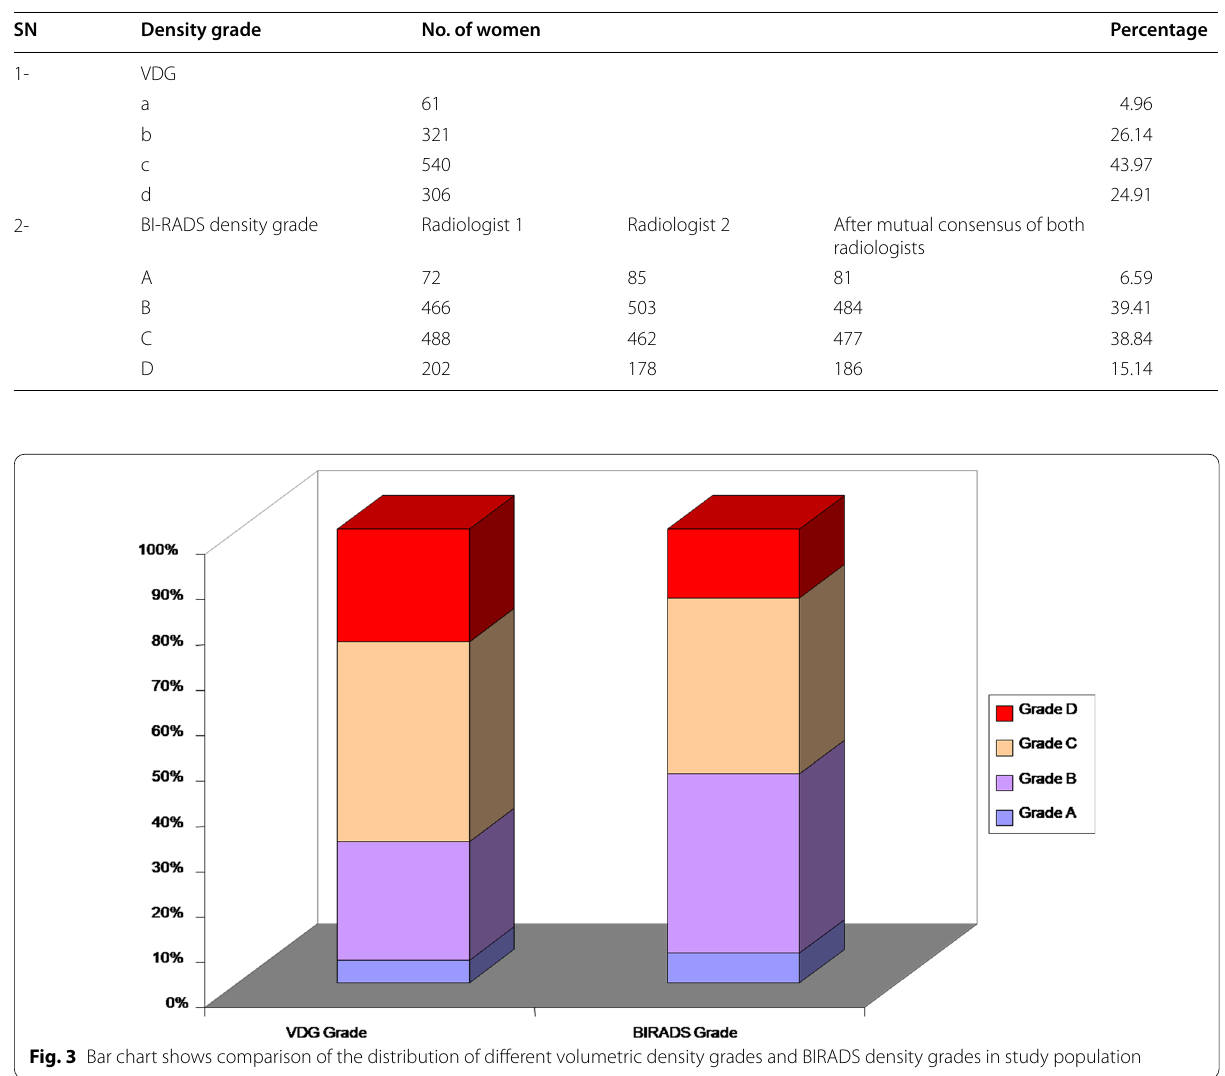
Table 1 Distribution of Study Population according to Breast Density Grade (VDG and BI-RADS Grades) (n